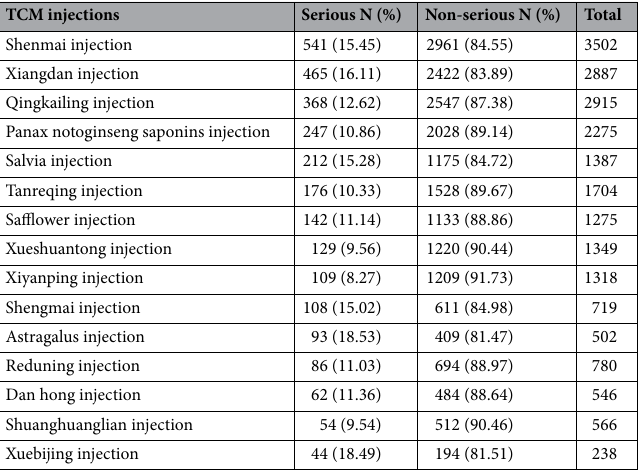
Table 3. Number and proportion of serious and non-serious reports by TCM injections (top 15).